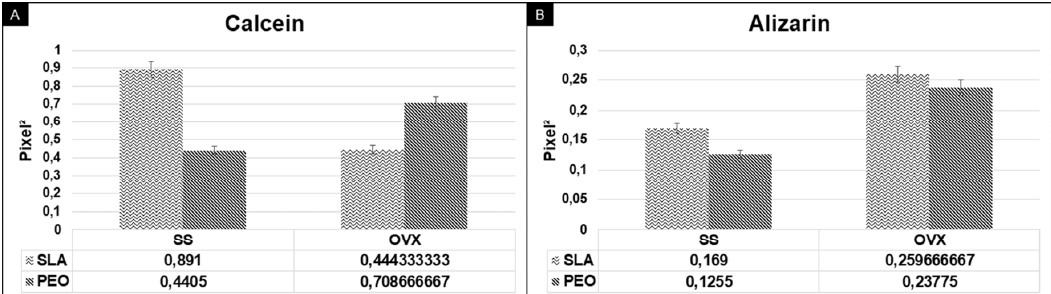
Figure 7. Bone dynamic data measured through the calcein ( A ) / alizarin ( B ) fluorochromes area, administered at 14 and 42 days respectively, according to surface coating methods (SLA and PEO) in each bone condition (SS and OVX).